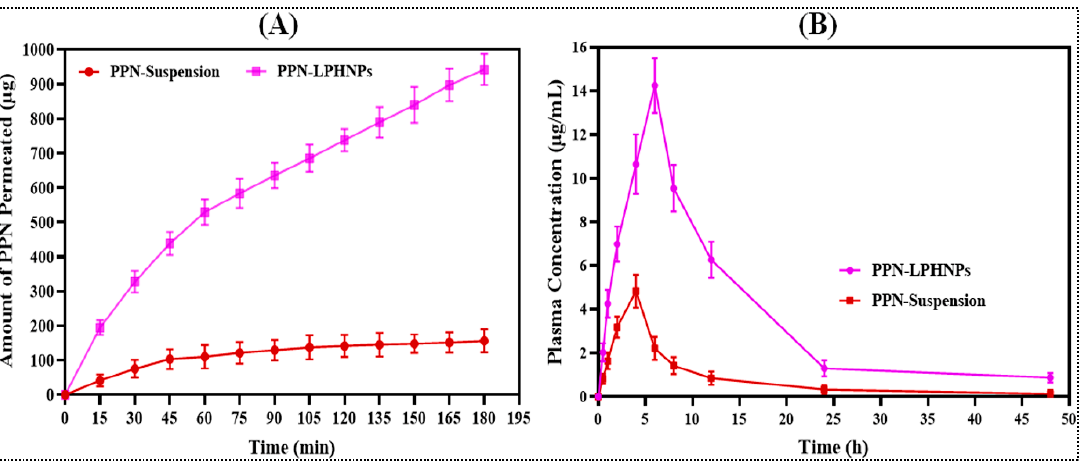
Figure 9. Image illustrating ( A ) comparative intestinal permeation profiles of PPN suspension and PPN-LPHNPs, ( B ) comparative plasma concentration vs. time profiles of PPN suspension and PPN-LPHNPs.